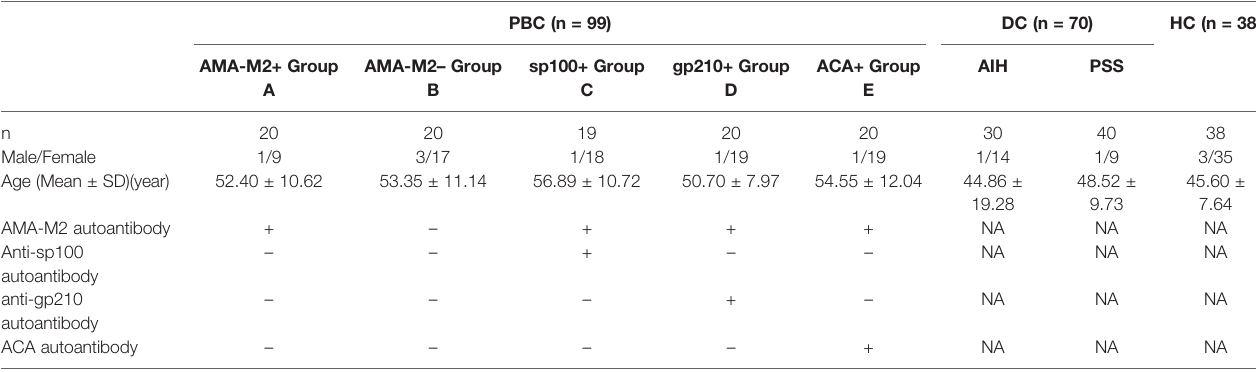
TABLE 1 | Sample characteristics and subgroups of lectin microarray